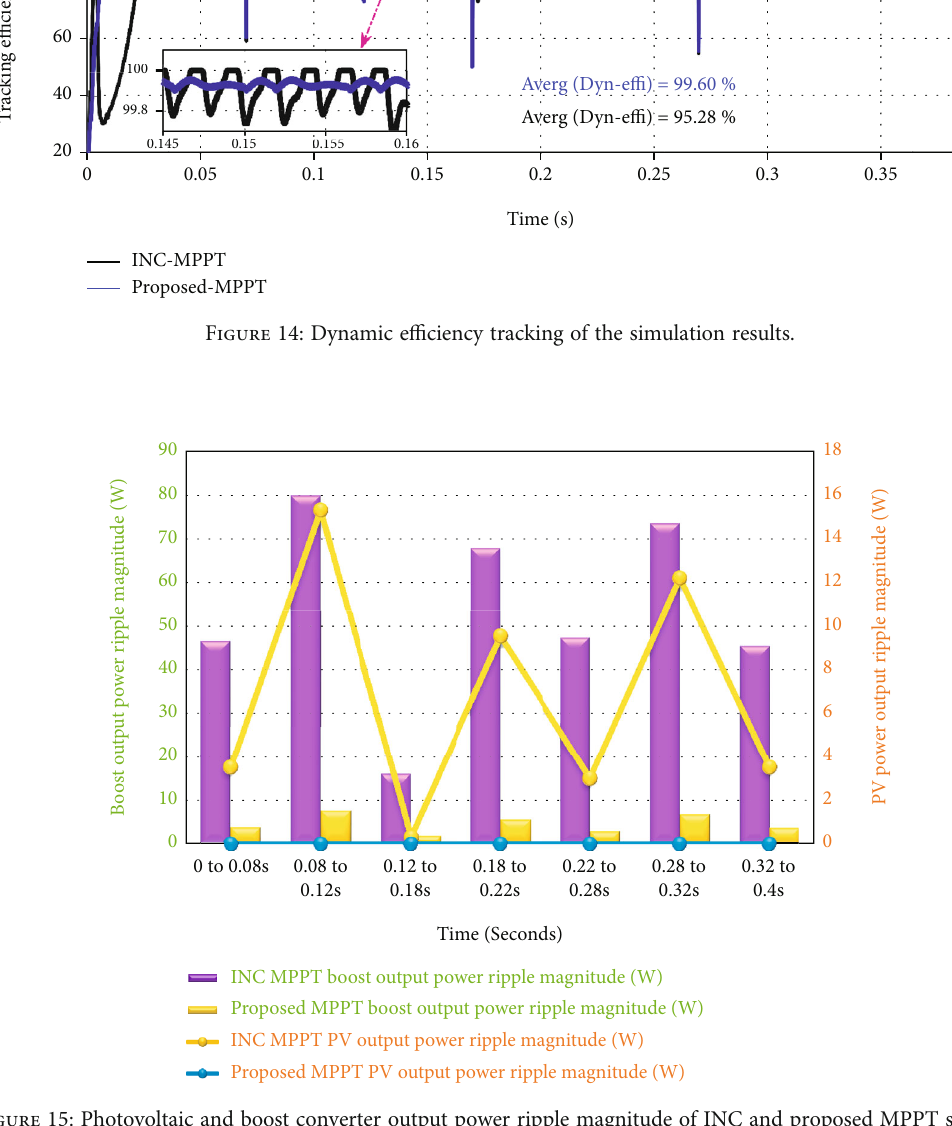
Figure 15: Photovoltaic and boost converter output power ripple magnitude of INC and proposed MPPT